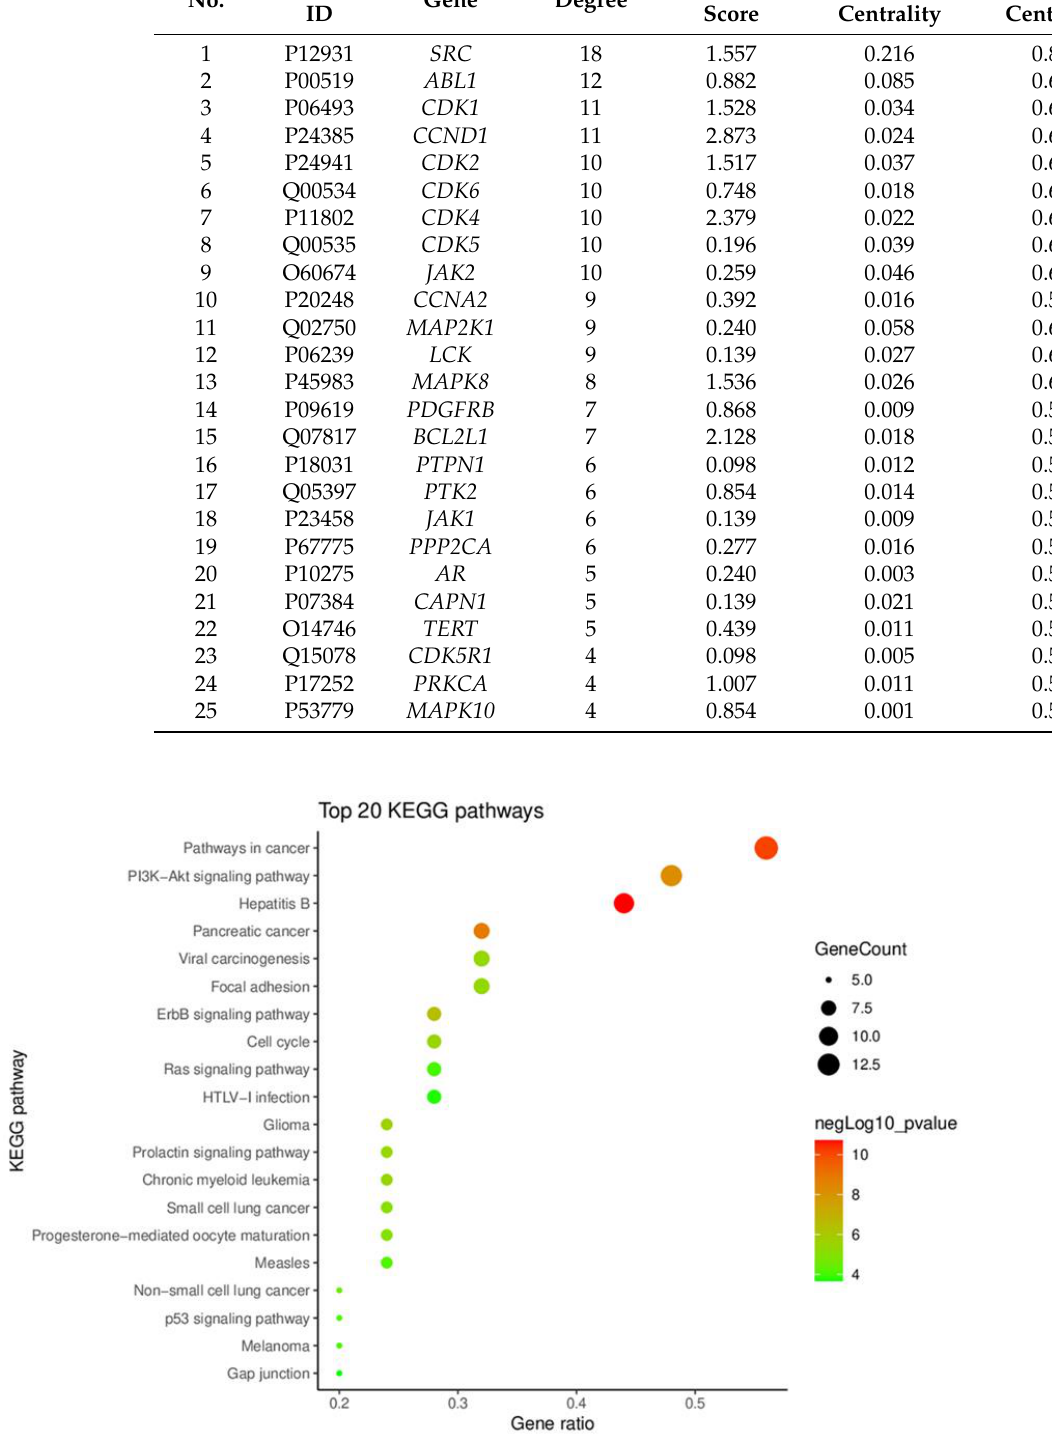
Figure 3. A bubble diagram of the top 20 pathways identified based on KEGG pathway enrichment analysis of key targets.